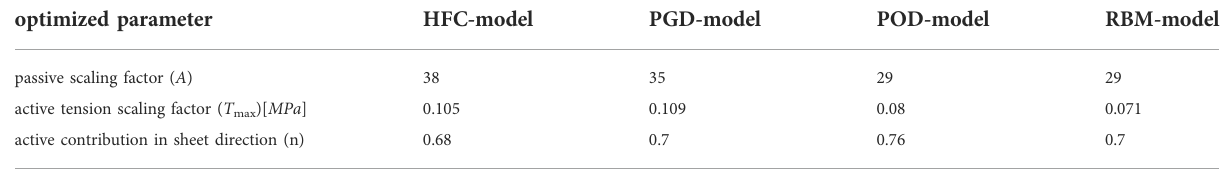
TABLE1Personalizedpassiveandactivetissueparameters(A, T max )andtheactivecontributioninsheetdirection(n)forthefourmodelswithdifferent fi ber orientation obtained by the four interpolation methods: HFC-model, PGD-model, POD-model, and